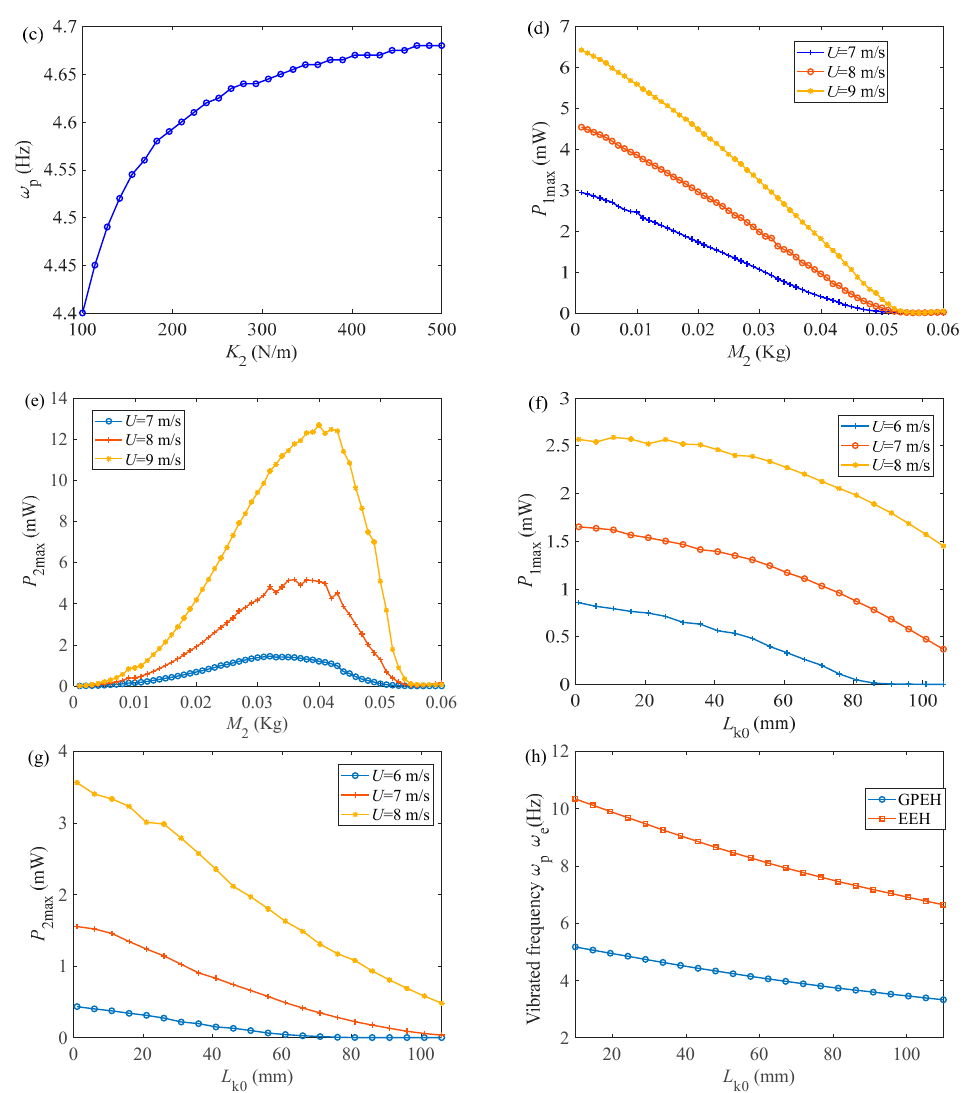
Figure 10. The influence of EEH parameters on output characteristics. ( a ) P 1max with increasing K 2 . ( b ) P 2max with increasing K 2 . ( c ) ω p with increasing K 2 . ( d ) P 1max with increasing M 2 . ( e ) P 2max with increasing M 2 . ( f ) P 1max with increasing L k0 . ( g ) P 2max with increasing L k0 . ( h ) The vibrated frequency with increasing L k0 Figure 10b is the output curves of spring stiffness K 2 versus EEH maximum output